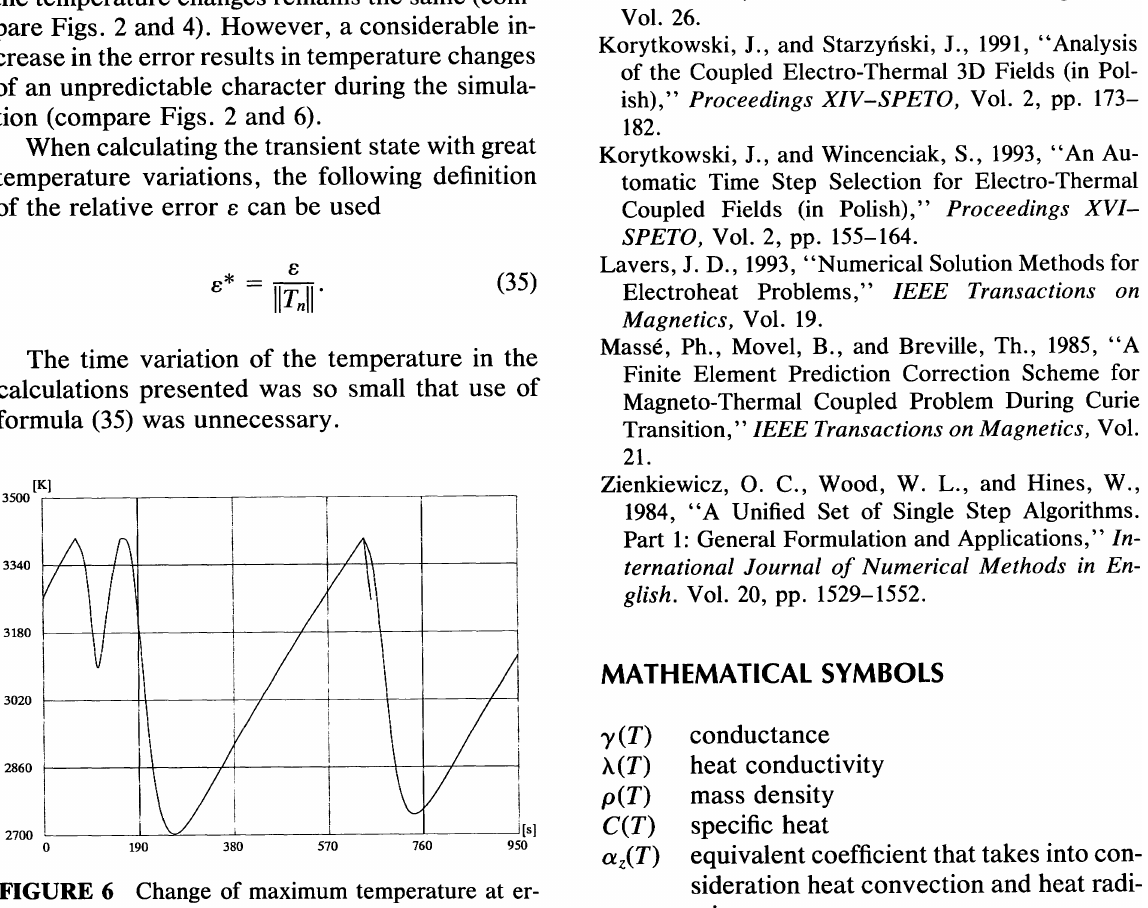
FIGURE 6 Change of maximum temperature at er ror e = 120 (W/m).